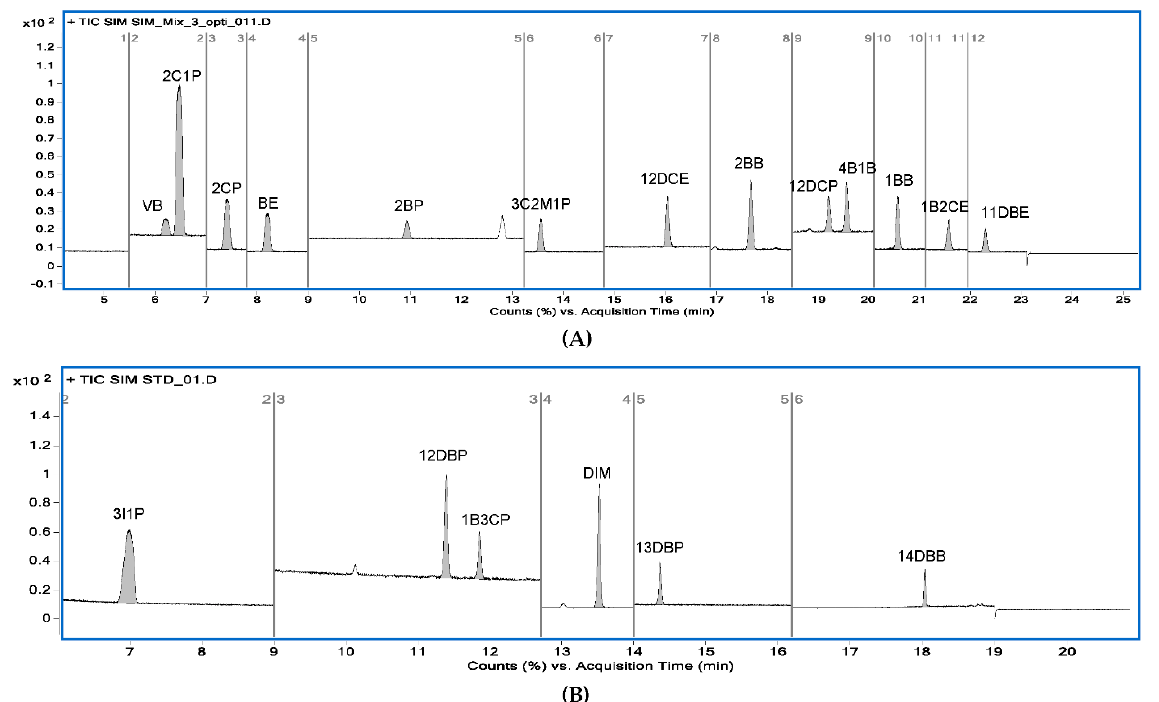
Figure 8. Typical GC − MS chromatograms of 19 alkyl halides using the scan mode. ( A ) Chromatogram for 13 alkyl halides obtained from method A; ( B ) chromatogram for 6 alkyl halides obtained from method B.